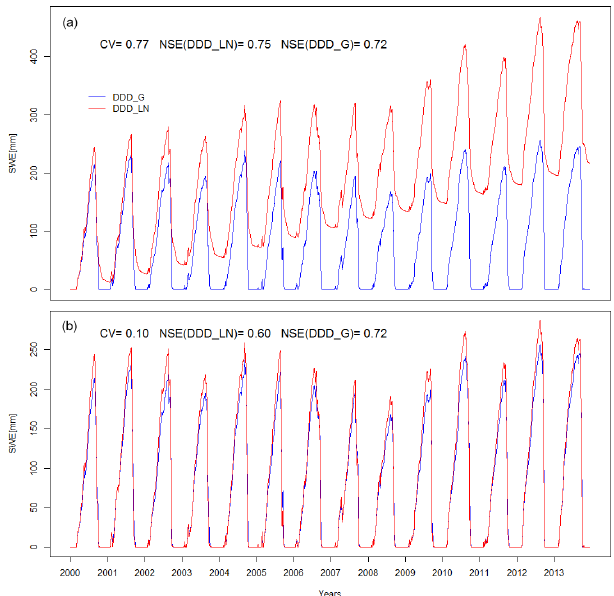
Figure 10. Time series of simulated SWE for the Masi catch- ment in Northern Norway with DDD_G (blue) and DDD_LN (red). In (a) SWE is simulated with optimized CV = 0.77, which gives a NSE = 0.75. In (b) SWE is simulated with adjusted CV = 0.1, which gives a NSE = 0.60. Using DDD_G gives a NSE = 0.72.